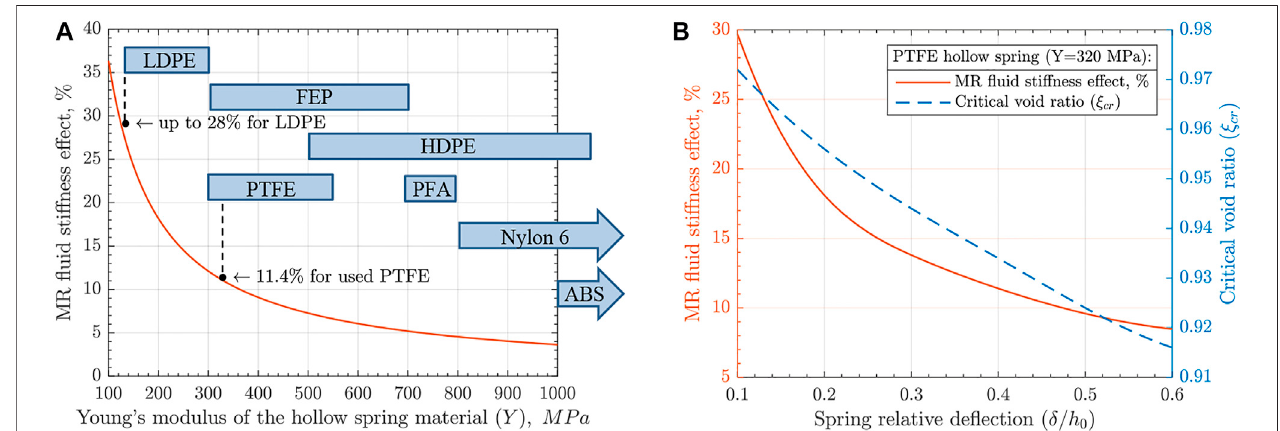
FIGURE8|(A) MR fl uidstiffnesseffectforaspringwiththeoptimized void ratio ξ (cid:1) 0 . 934(consideringarelativespringde fl ection of (cid:1) δ (cid:1) 0 . 4and thesafety factorof n τ (cid:1) 2 for the operational force) and various materials Young ’ s moduli at the magnetic fi eld of B (cid:1) 0 . 5T. The bars with abbreviations indicate typical modulus ranges of these polymers. (B) MR fl uid stiffness effect and critical void ratios for different spring relative de fl ections (considering a PTFE hollow spring material ( Y (cid:1) 320 MPa) and the safety factor of n τ (cid:1) 2) at the magnetic fi eld of B (cid:1) 0 . 5T.